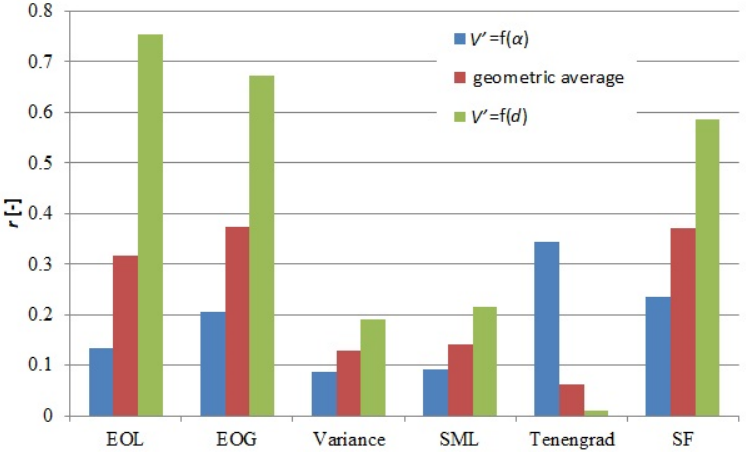
Figure 7. Obtained values of correlation coefficients between the dependencies V' = f( α ) and observer indications, V' = f( d ) and observer indications, and the geometric average value of both correlation coefficients.